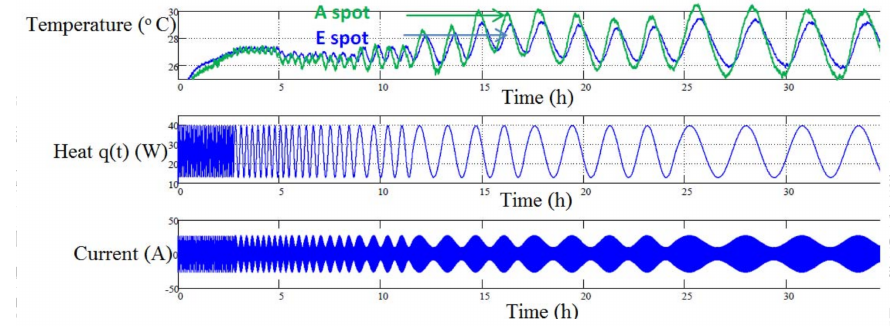
Figure 7. Outcomes from the frequency-based ETIS procedure [36].